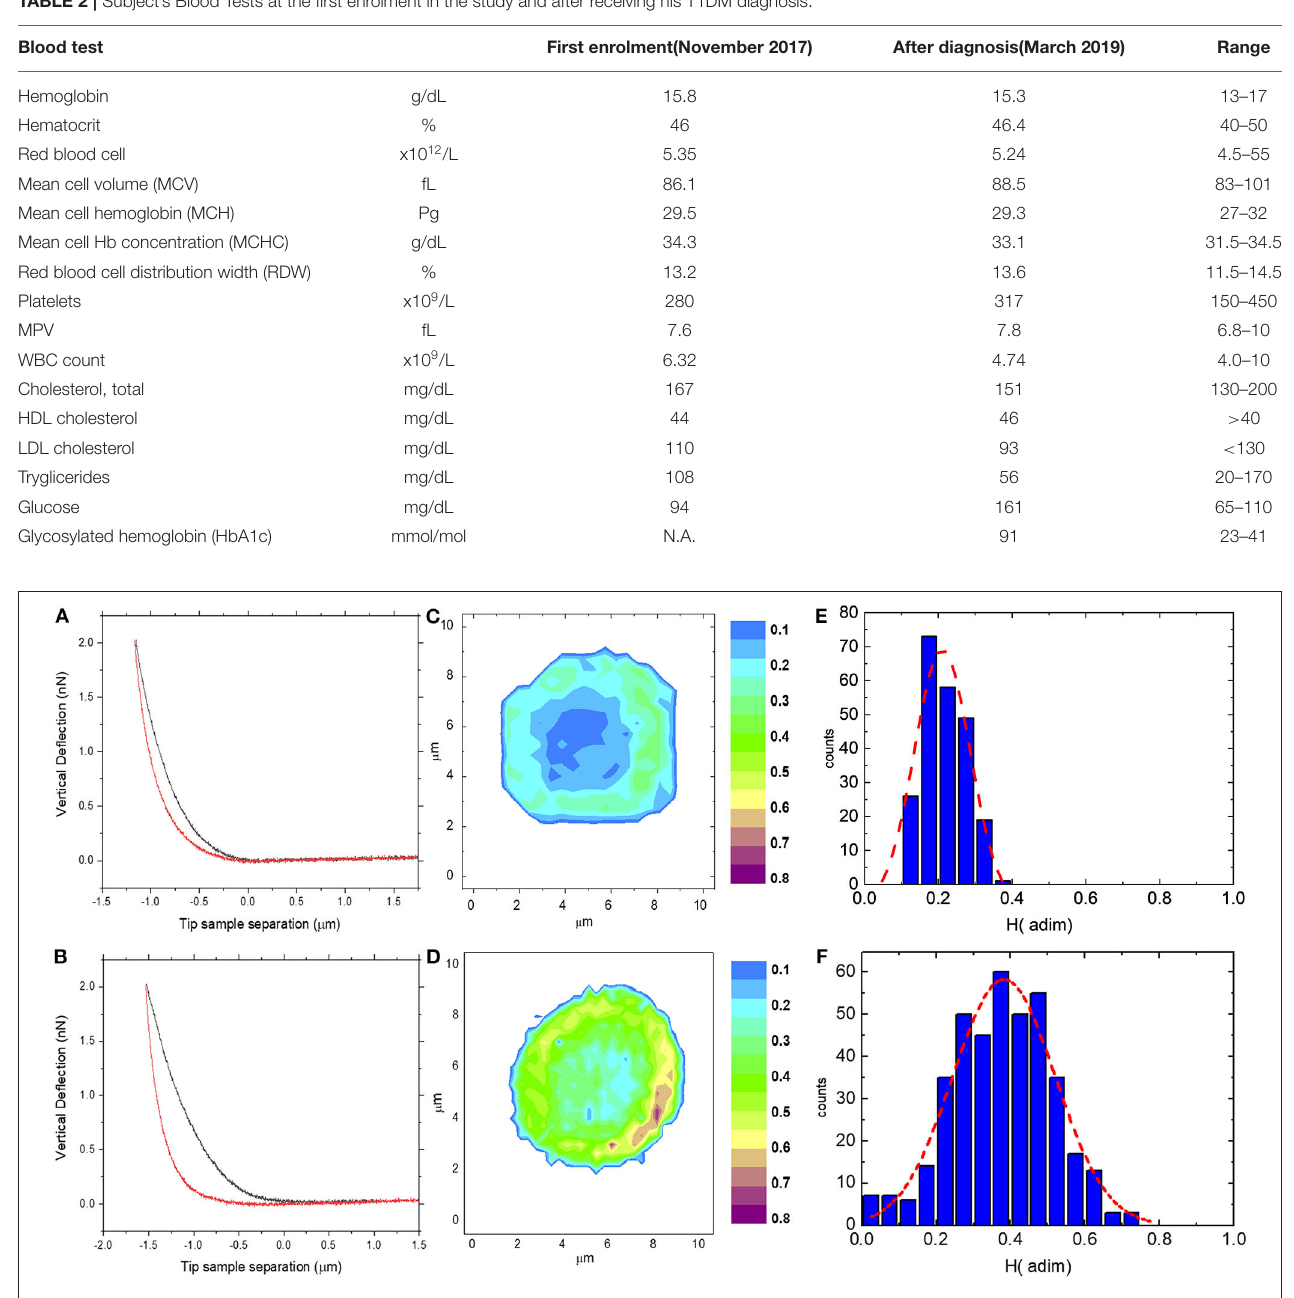
FIGURE 1 | Two representative Force-Distance (FD) cycles acquired on a control subject (A) and on the pathological subject (B) ; two representative erythrocyte H maps acquired on control (C) and on the pathological subject (D) with the corresponding histogram of H values (E,F)